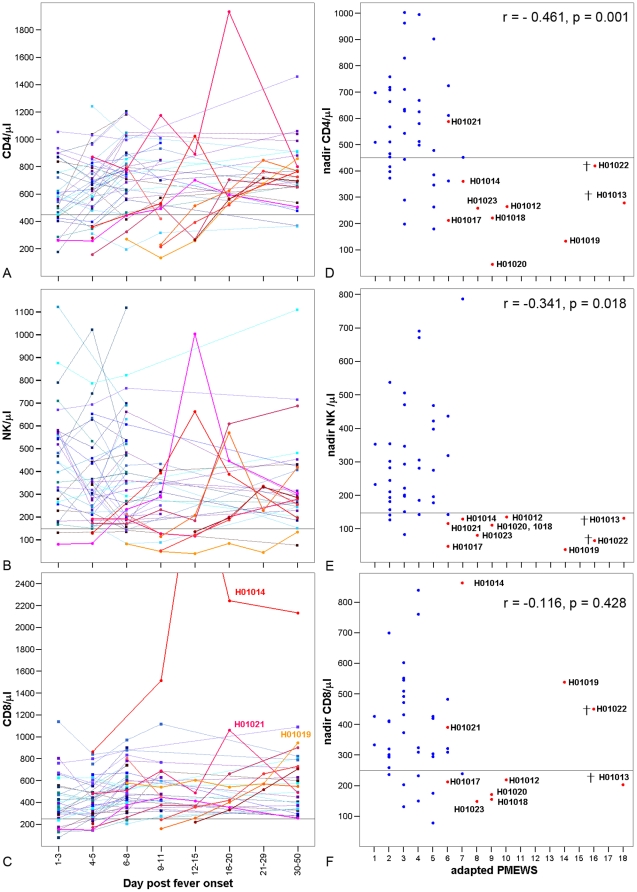
T and NK cell counts in severe versus mild influenza.Panel's a–c show lymphocyte subset counts by time interval since onset with each line representing an individual patient. Horizontal solid lines represent the lower limit of the normal range. Panels d–f show nadir values for lymphocyte subset counts versus pandemic medical early warning score (PMEWS) with Spearman's correlation coefficients. The 2 patients that died are indicated ( ) because they were only assessed at one or two time points. Results are shown for 10 patients with severe illness (red tone symbols and lines) and 39 patients with mild illness (blue tone symbols and lines).